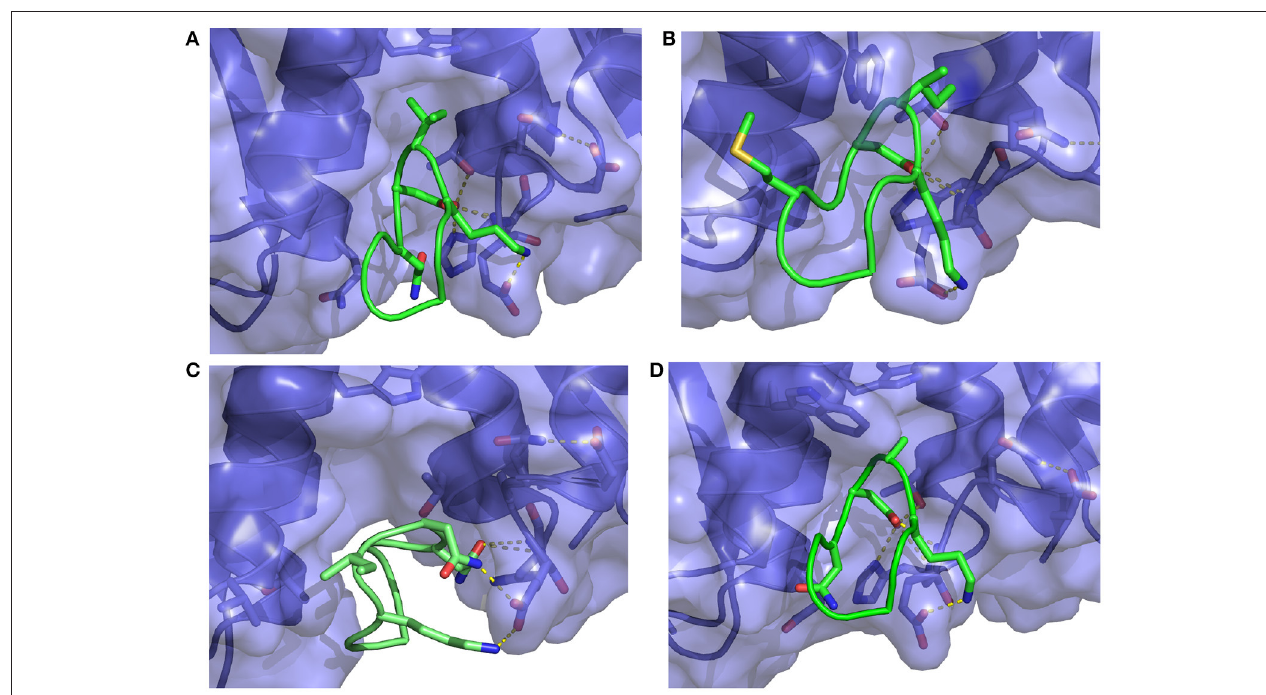
FIGURE 8 | Representative structures extracted from the simulations of (A) the S362A mutant cyclic peptide (M1 in Table 1 ) and (B) the S362A:L368M double mutant cyclic peptide (M2), (C) the D366N cyclic peptide (M3), and (D) the I365A mutant cyclic peptide (M4) with the HIV integrase LEDGF-binding domain. All interactions shown were previously described in Figure 7 . Notice in (C) that the D366N mutation causes severe distortion of the peptide as well as the receptor relative to the bound conformation of the